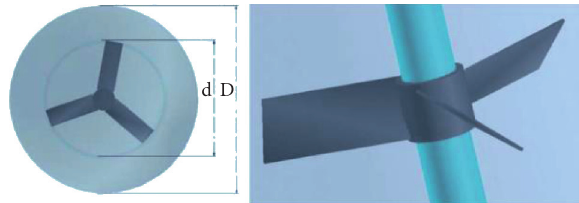
Figure 7: Three-blade impeller sketch